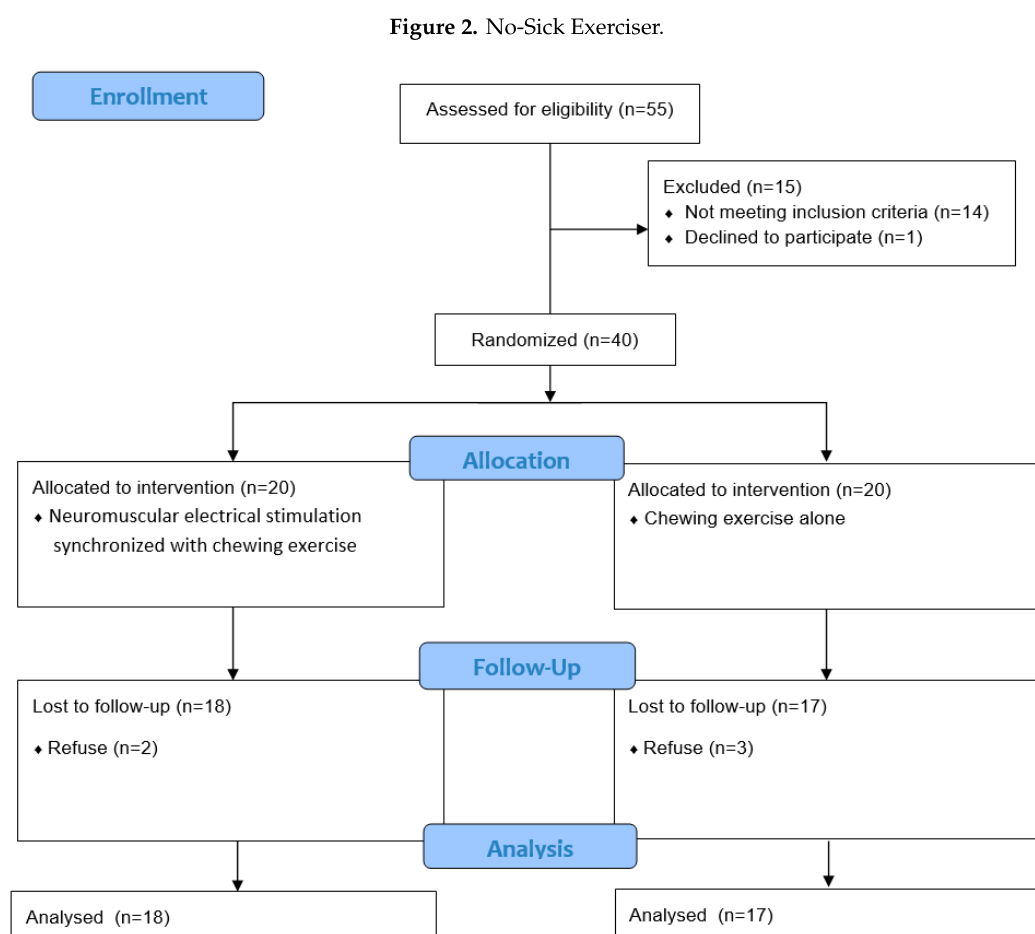
Int. J. Environ. Res. Public Health 2020 , 17 , x